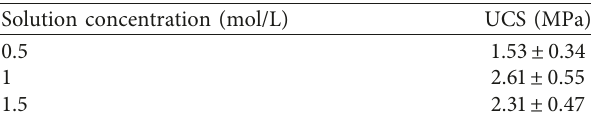
Figure 6: The soil column after the MICP process with different solution concentrations: (a) 0.5mol/L; (b) 1mol/L; (c) 1.5mol/L. Table 4: Soil UCS after the biocement process for 3 soil